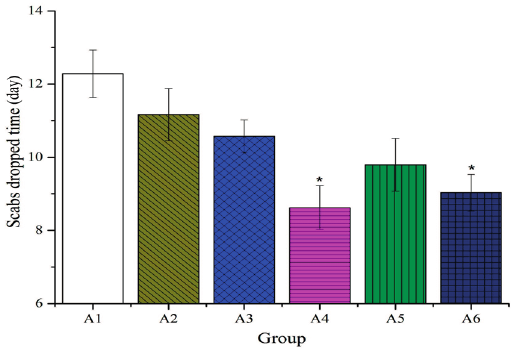
Figure 2. Effect of different concentration or fractions of BBO on the scabs dropped time in rats. Values are expressed as mean ± S.D. ( n = 4 animals). * : p < 0.05 vs.